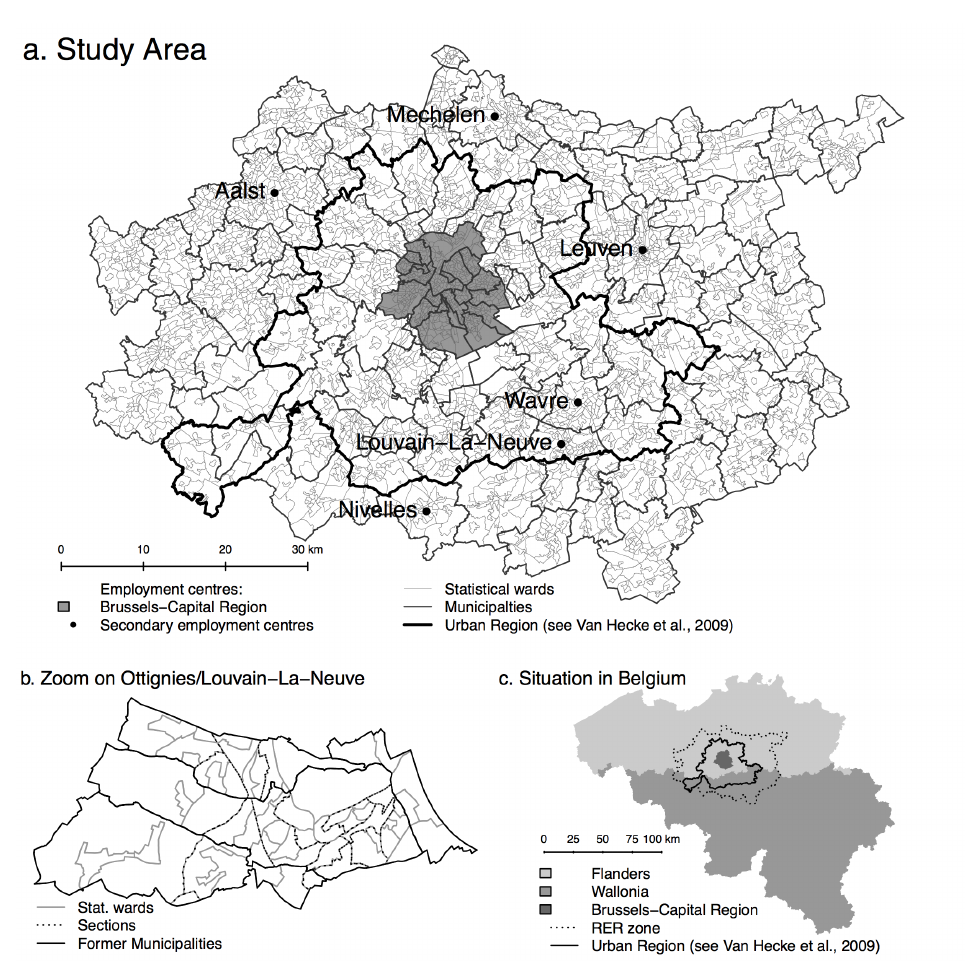
Figure A.1: Study area and basic spatial units